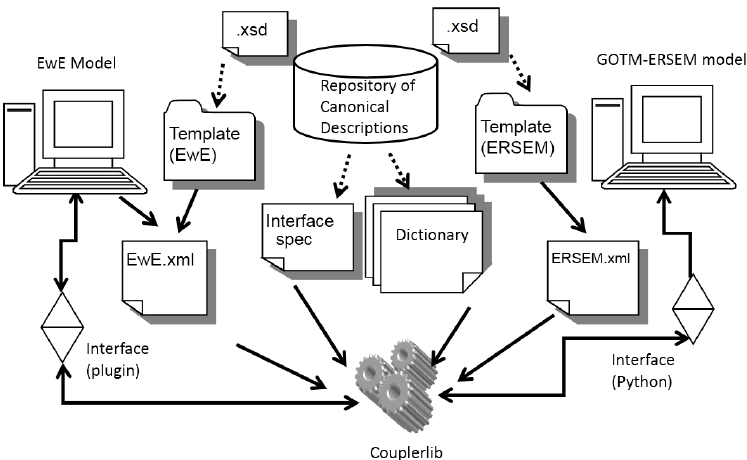
Figure 1. Outline of the information sources in the form of XML files and model components between two models running in network mode with a twin copies of